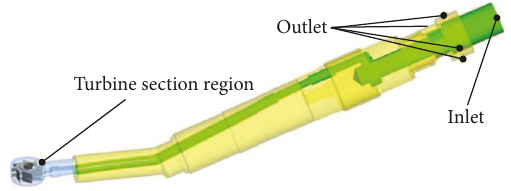
Figure 7: Air turbine handpiece model.